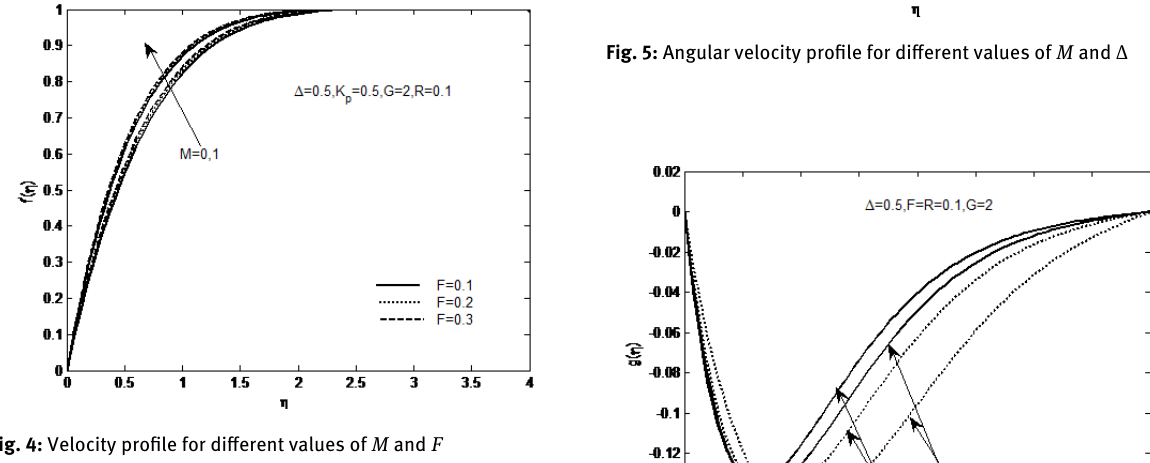
The velocity profile for the dimensionless parameters M and K p is shown in Fig. 3 with the fixed values of ∆ = 0.5, F = R = 0.1 and G = 2. The velocity profile ob- served to decelerates in the boundary layer in the pres- ence/absence of magnetic parameters due to the porous matrix. It is also noted that the reverse effect appears to be right in the case of the magnetic parameter. Fig. 4 illus- trates the effect of M and F on velocity profile. It is clear that the increase in microinertia coefficient increases the velocity profile at all points in the flow domain for both presence/absence of magnetic parameter. The present re- sult is in good agreement with the outcome of Rashidi et al. [43] by withdrawing the magnetic parameter, i.e. M = 0 from the velocity